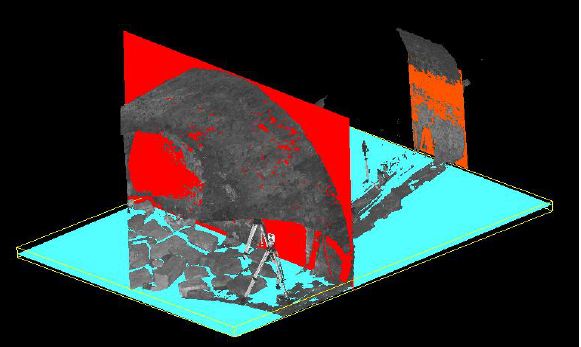
Fig. 3. Planes detected by the PCL algorithm ( planes are marked by the same colour)